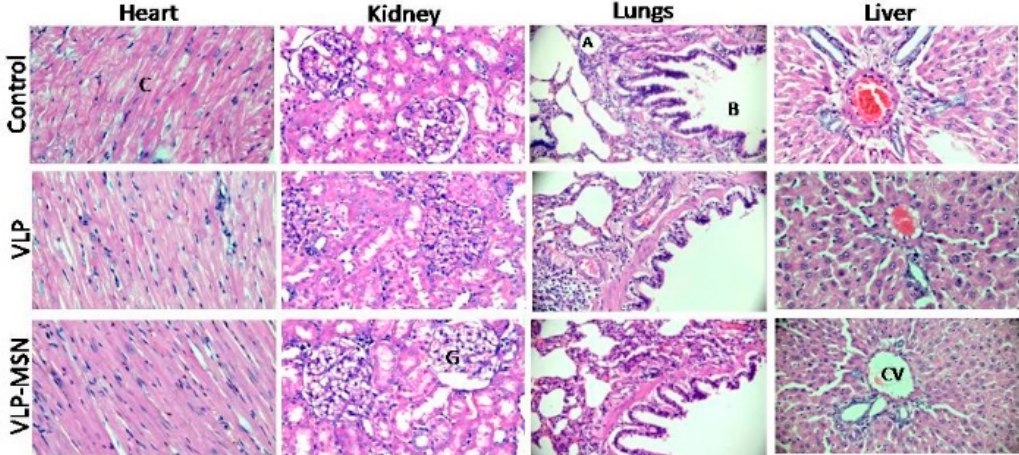
Figure 10. Histopathological evaluation of various vital organs i.e., heart, kidney, lung and liver of rats (At 40× objective lens in Accu-Scope 3001 Trinocular microscope fitted with a 5 megapixel camera) in control and after oral administration of VLP-MSN and VLP. CV = Central vein of liver, A = Alveolar sacs and B = bronchiole in lung, G = Glomerulus in kidney, C = Cardiomyocytes of heart.